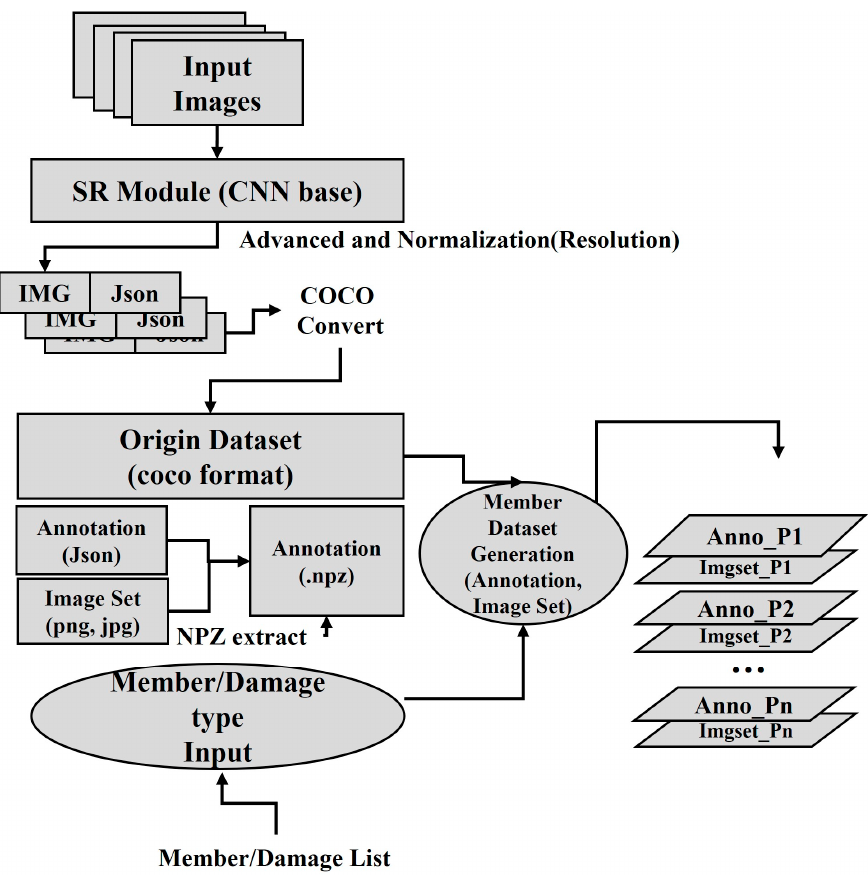
Figure 5. Dataset generation process.